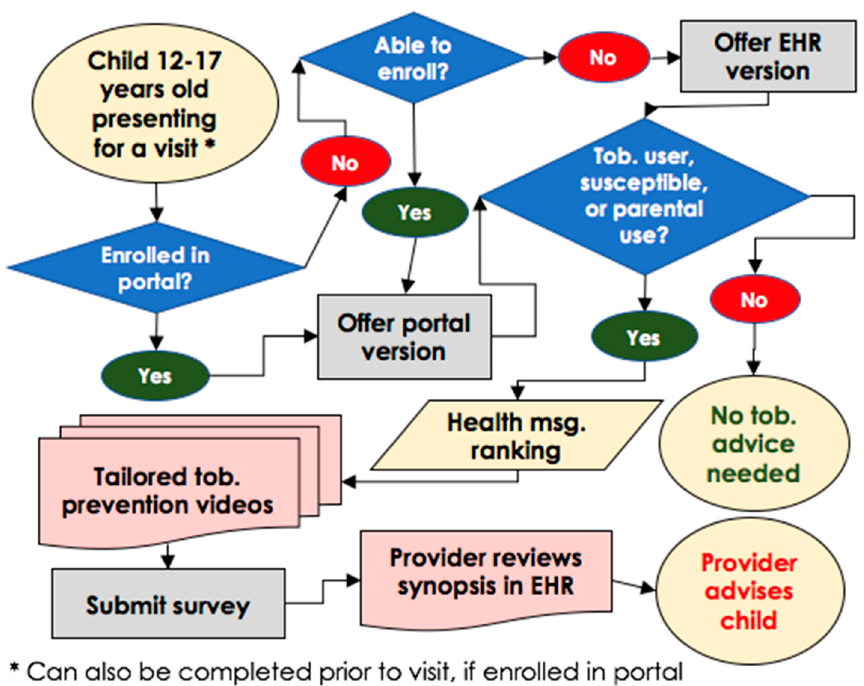
Figure 2. Electronic health record (EHR)-based screening clinic workflow.